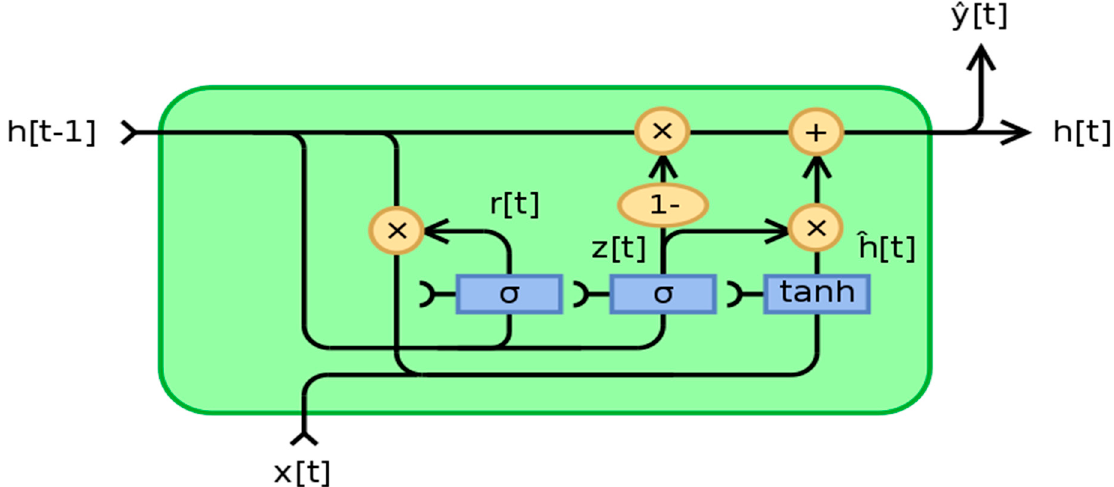
Figure 3. GRU model.